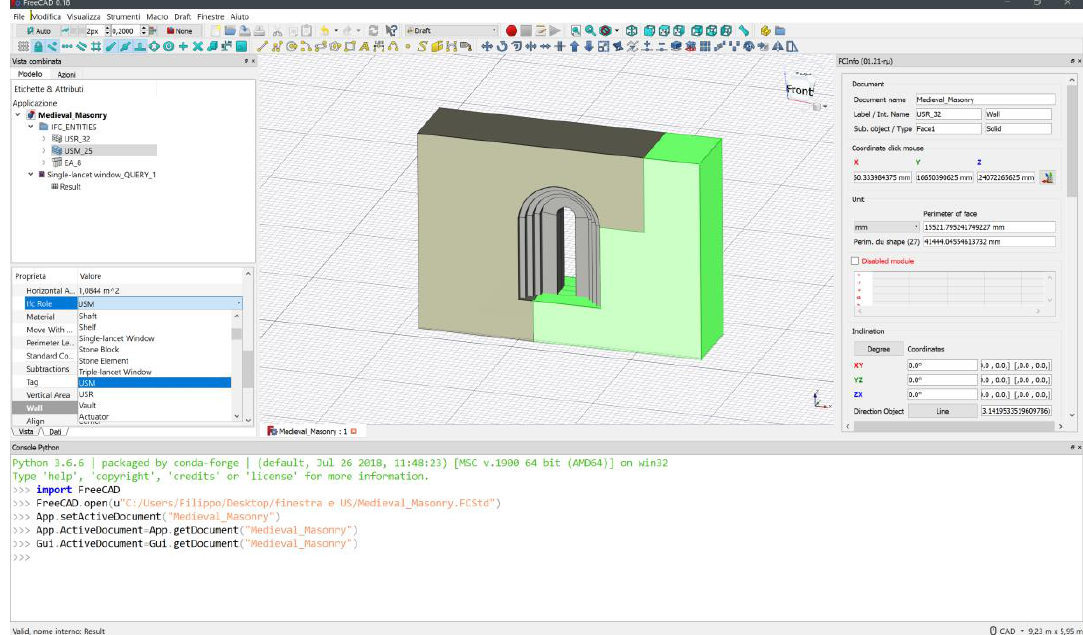
Figure 8. Example of a medieval stone wall: IFC classification of stone masonry as stratigraphic unit (USM on the right of single-lancet window—see also Figure 7) available on the drop-down menu after the implementation of ifcWall entity and ArchComponent.py.